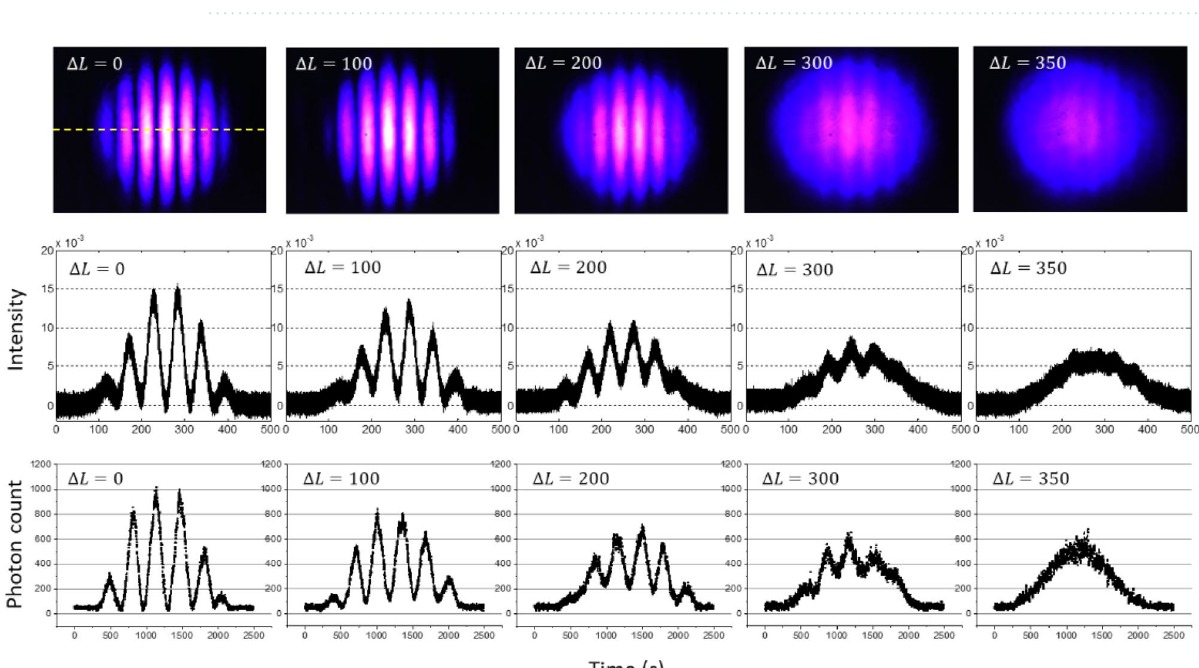
Figure 4. Observations of MZI fringes for different path lengths in Fig. 1. (Top) CMOS captured 2D images for cw coherent light at 200 µ W . (Middle) Slit-scanned fringes for the Top. (Bottom) Slit-scanned fringes for attenuated single photons in Fig. 2. The unit of (cid:31) L is µ m . The horizontal dashed line in the upper left panel is an example of the slit scanning direction for the middle and bottom